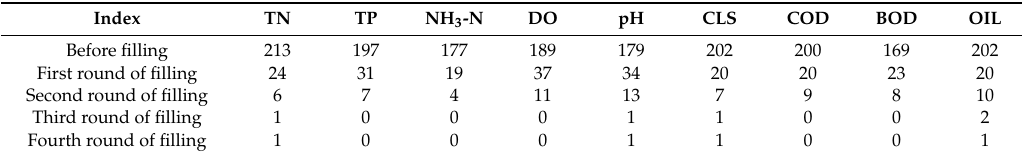
Table 3. The number of abnormal values of each water indicator.